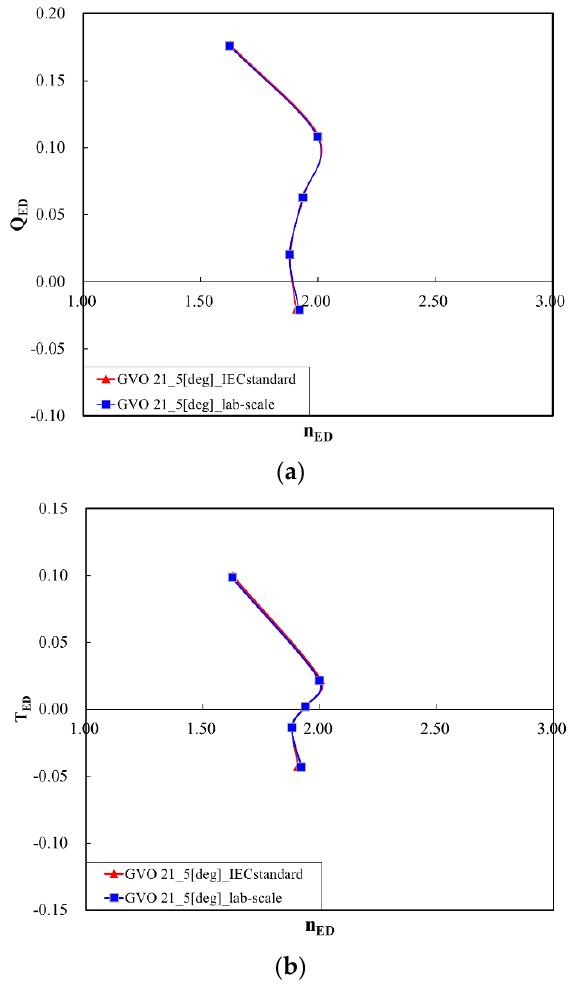
Figure 8. S-shaped characteristics of model scales at 21.5° GVO: ( a ) Speed factor vs. discharge factor; ( b ) speed factor vs. torque factor.